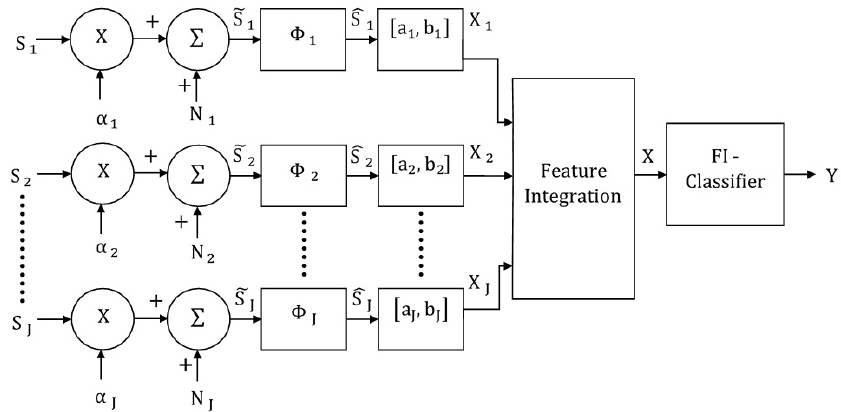
Figure 3. Block diagram of the feature-integrating multimodal classification system.